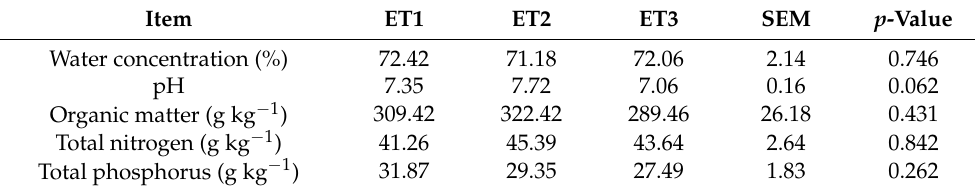
Table 3. The physicochemical properties of feces in the three enterotypes.